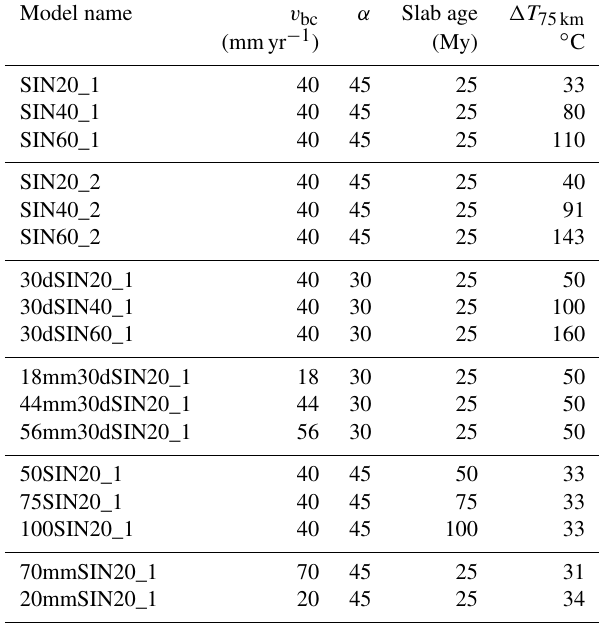
Table 2. Variation in temperature along-strike for the reference model (SIN20_1) and those derived from